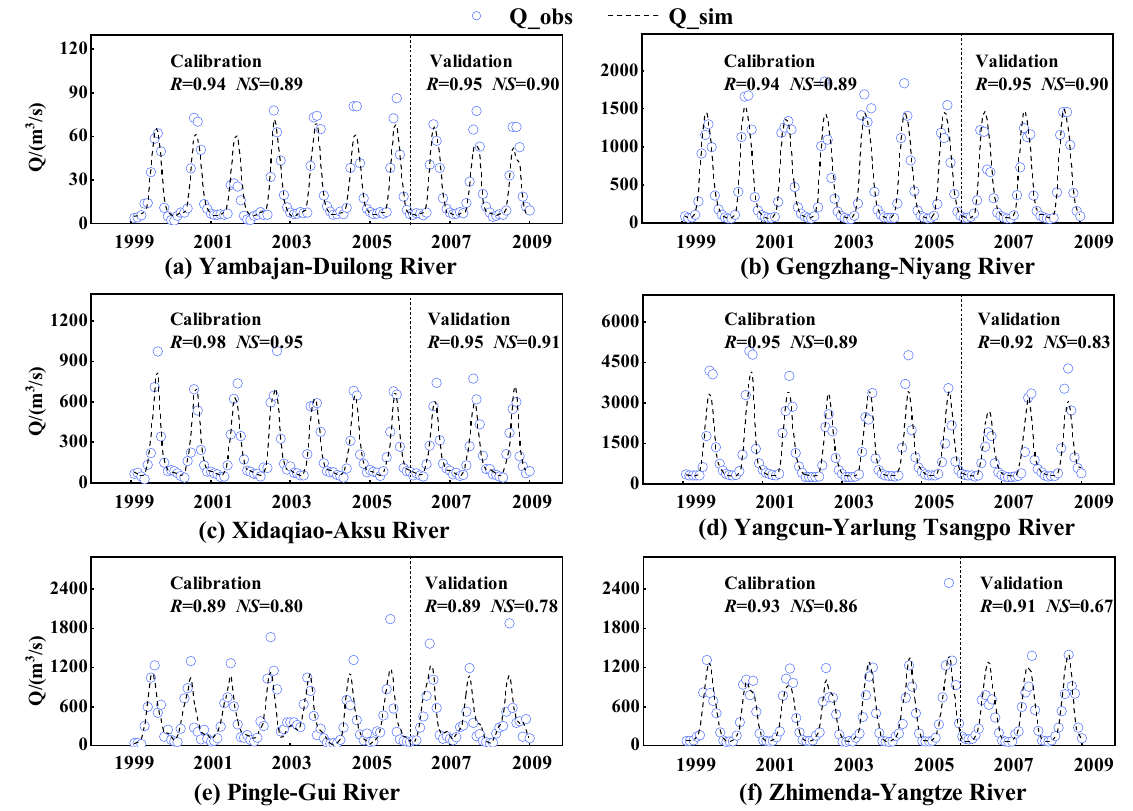
Figure 6. Observed vs. simulated monthly runoff at typical stations during the calibration and validation period: ( a ) Yambajan Station of Duilong River; ( b ) Gengzhang Station of Niyang River; ( c ) Xidaqiao Station of Aksu River; ( d ) Yangcun Sation of Yarlung Tsanpo River; ( e ) Pingle Station of Gui River; ( f ) Zhimenda Station of Yangtze River.